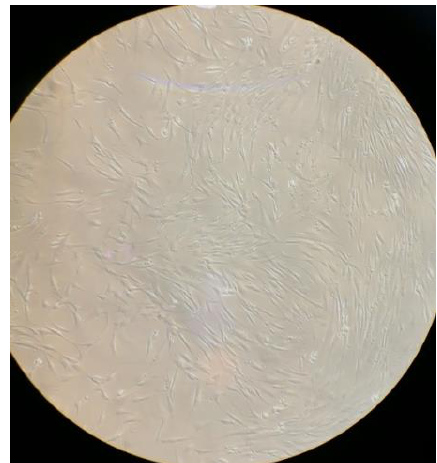
Figure 1. Inverted microscopic photographs of the morphology of mesenchymal stem cells